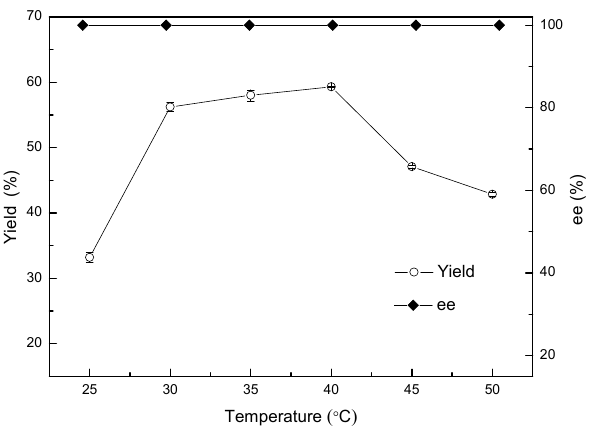
ff ect of temperature on the asymmetric Figure 6. Effect of temperature on the asymmetric reduction. Figure 6. E